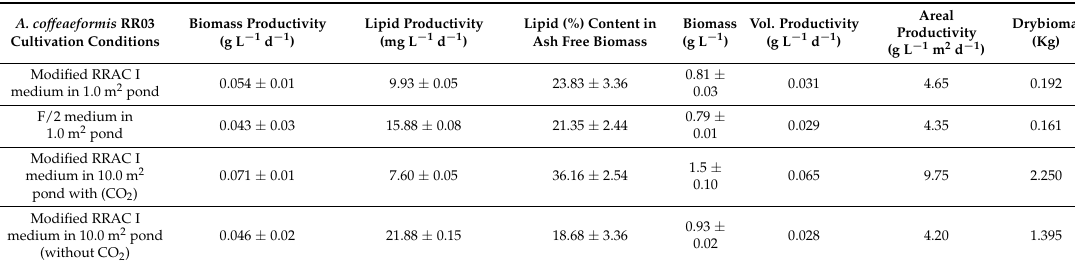
Figure 1. Amphora coffeaeformis RR03 cultivated in the modified CFTRI-RRAC I medium and F/2 control medium at different intervals in 1.0 m 2 open raceway pond was subjected to the analysis of ( a ) dry biomass, ( b ) cell number, ( c ) chlorophyll-a, and ( d ) total lipid content. Table 1. Biomass, lipids, volumetric, and areal productivity of A. coffeaeformis RR03 cultivated in 1.0 m 2 and 10.0 m 2 open raceway ponds.